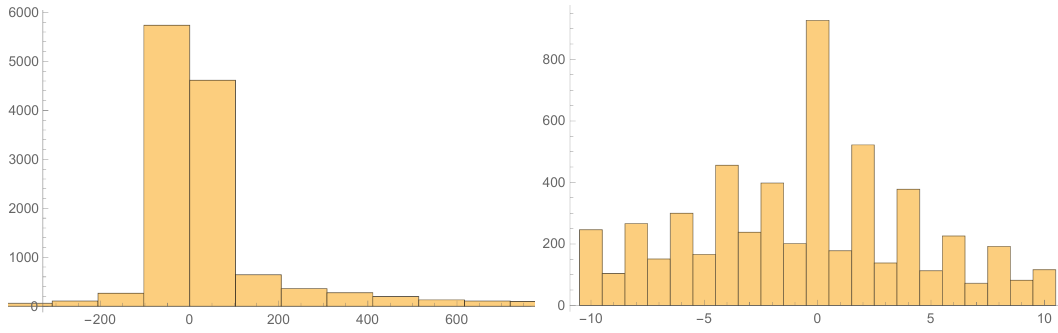
Figure 1 . A histogram of the coe(cid:14)cients of f 1 a for the 13 642 twined elliptic genera. The coe(cid:14)cients peak near zero and as can be seen on the zoomed in histogram on the right this peaking is potentially larger than expected. We also see that even integer coe(cid:14)cients appear substantially more